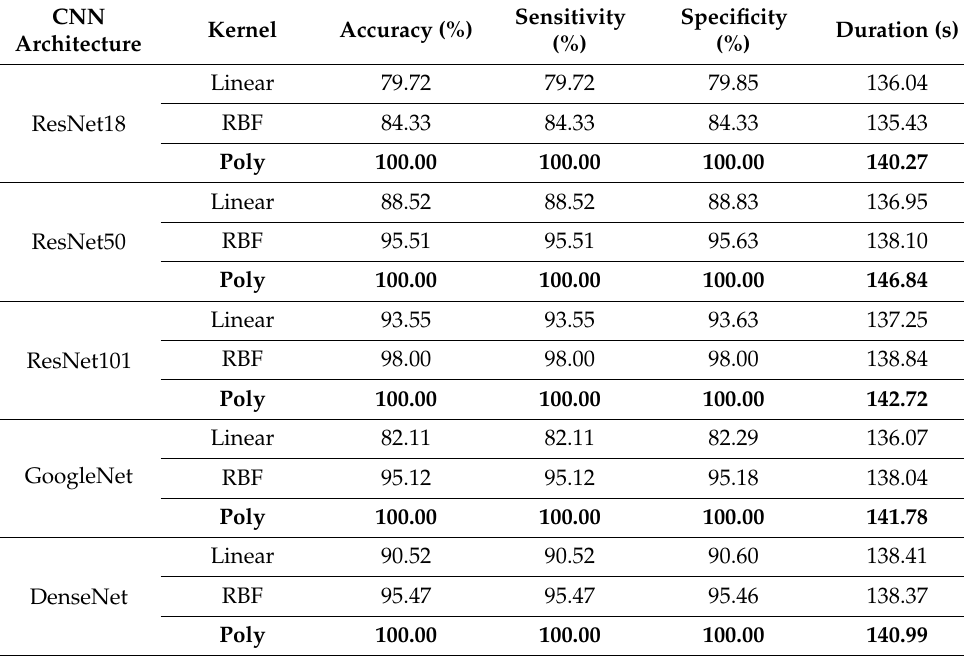
Table 4. Results of Experiment on Four-Class DRIVE